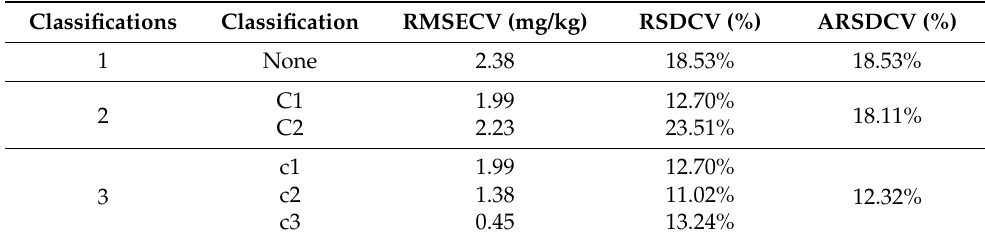
Table 2. Results of classification regression